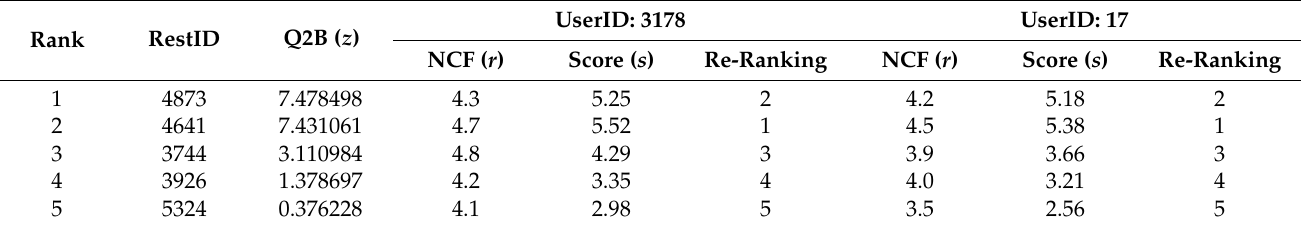
Table 10. Re-rank model results.